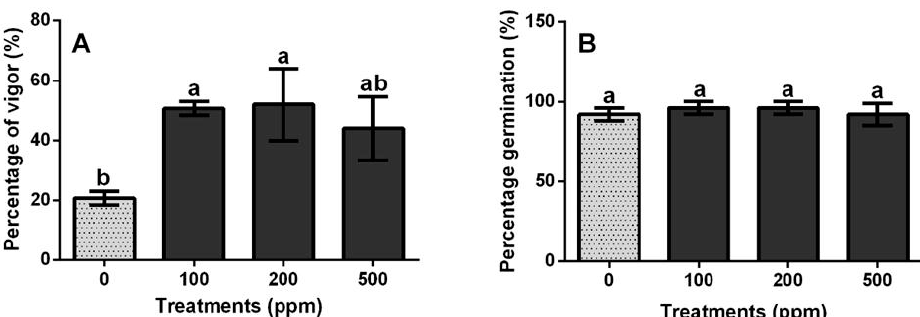
Figure 2. Vigor ( A ) and germination ( B ) percentages in Capsicum annuum L. seeds treated with ZnO-zinc oxide naoparticles (ZnO-NPs) at different concentrations (0, 100, 200 and 500 ppm). The bars represent the mean ( n = 4) ± standard deviation. Different letters are statistically different (Tukey, p ≤ 0.05) and represent the differences between treatments.